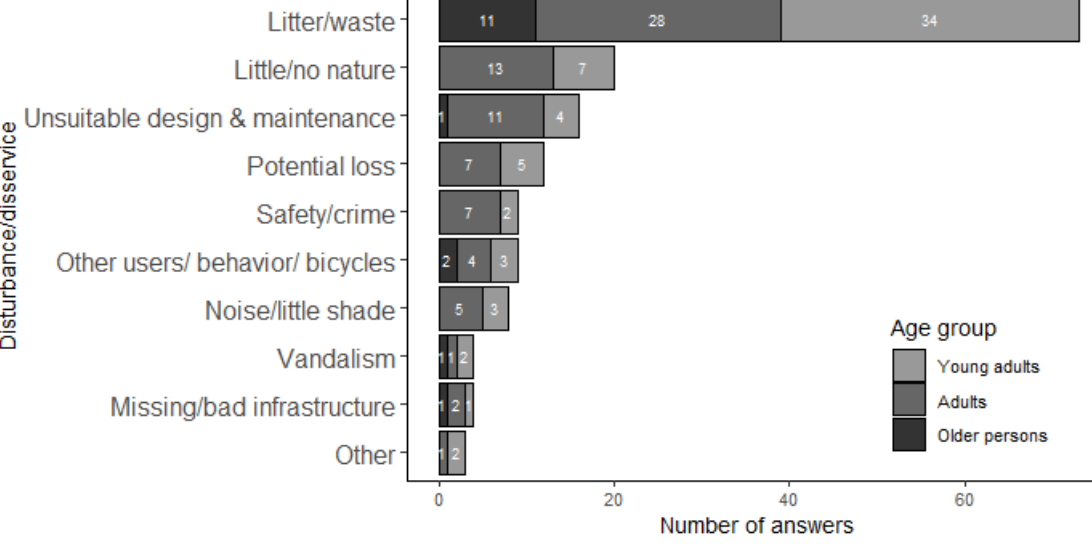
Figure A1.11: Frequencies of perceived disturbances/disservices (categorized answer from open question) on brownfields mentioned by respondents of different age groups in Leipzig. Multiple answers were possible. The white numbers indicate the number of mentions for each age group